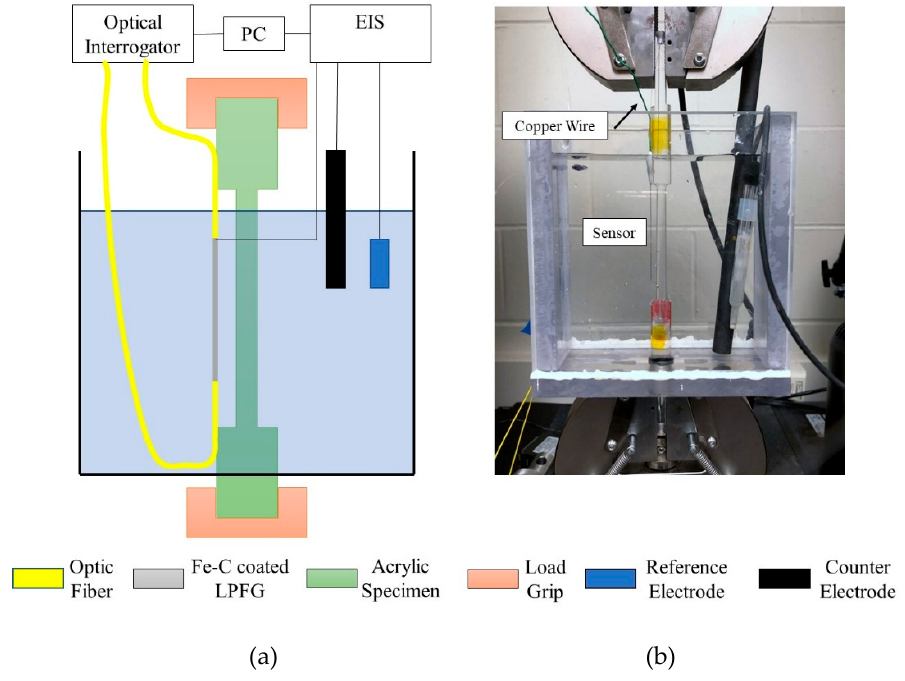
Figure 4. Tensile test setup of a Fe-C coated sensor in 3.5wt.% NaCl solution: ( a ) schematic view, and ( b ) laboratory test setup.